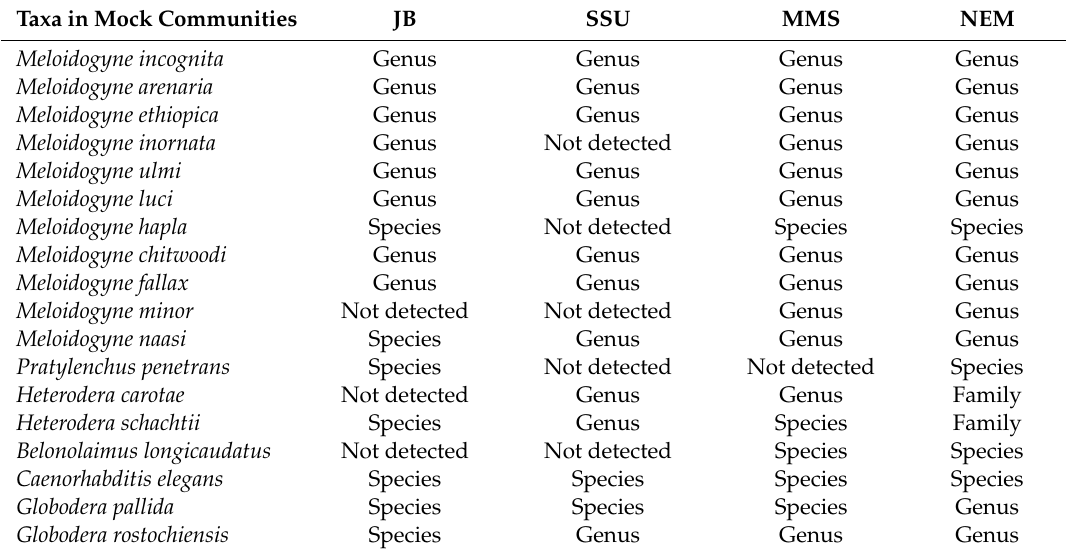
Table 2. The e ffi ciency of four metabarcoding primers in the detection of taxa in mock communities using Illumina